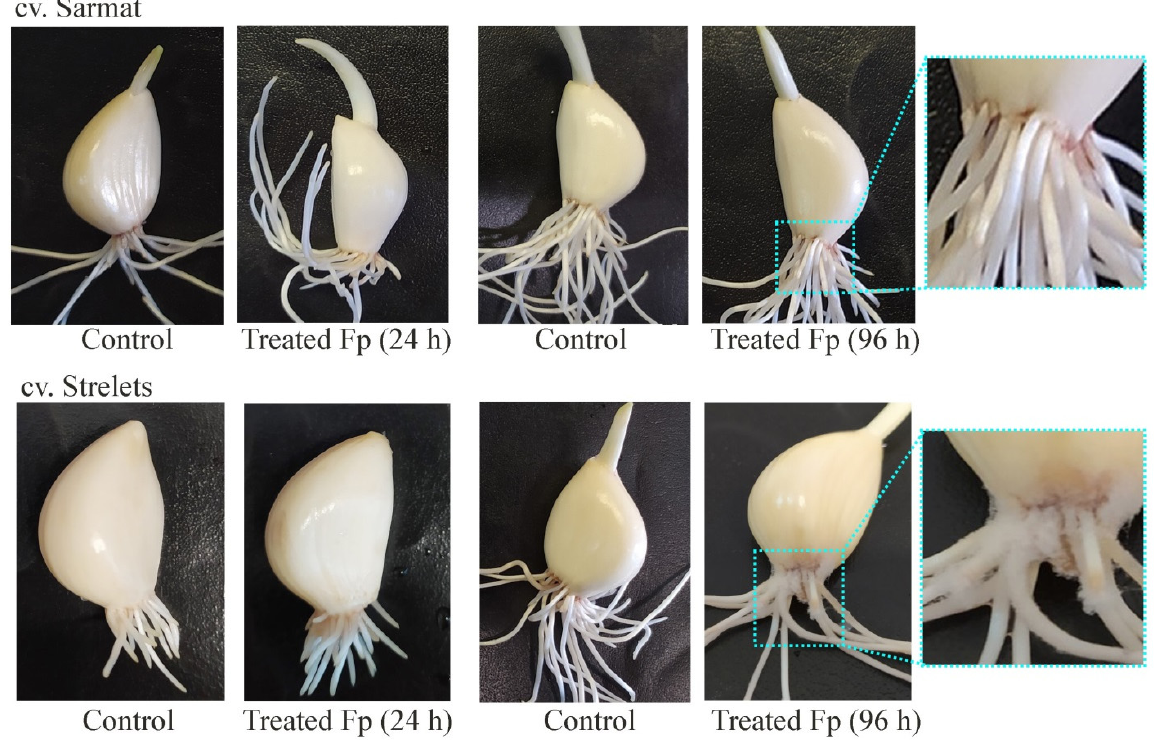
Figure 4. Symptoms of Fusarium rot disease in infection-resistant (Sarmat) and -susceptible (Strelets) garlic cultivars. Cloves were soaked in the suspension of F. proliferatum (Fp) conidia for 5 min and analyzed after 24 and 96 h; control cloves were treated with distilled water.